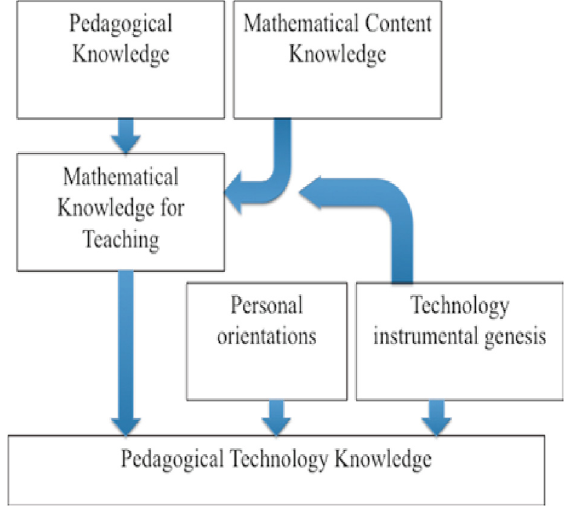
Figure 4. The PTK framework proposed by Thomas and Palmer [9].